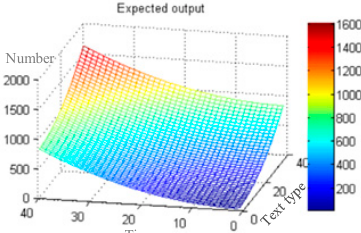
Figure 7. Predicted data.